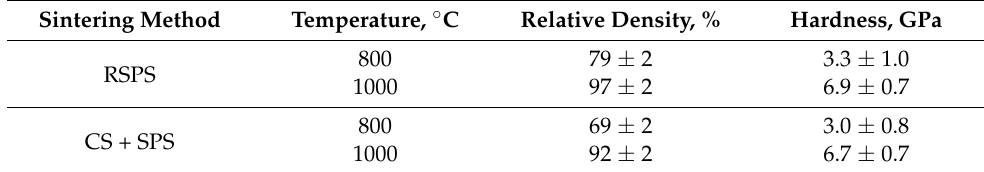
Table 3. Relative density and hardness of samples after consolidation.